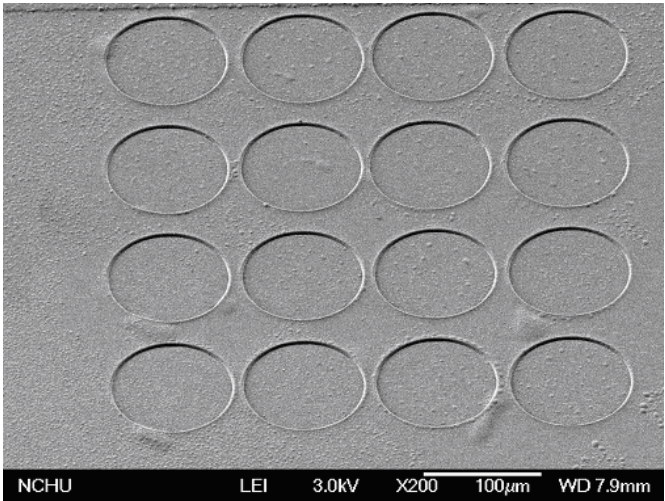
Figure 9. SEM image of the pressure sensor after depositing the parylene film.